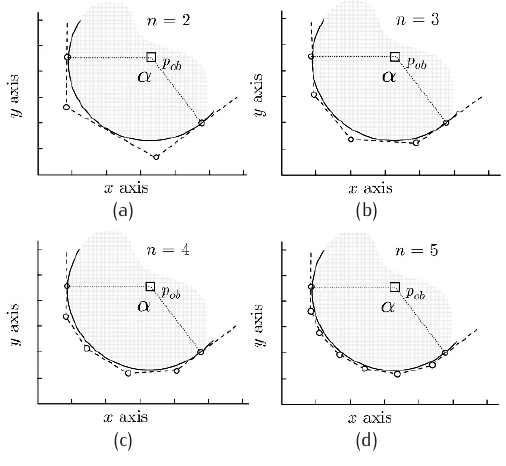
Figure 2. Effect of the number of via points on path